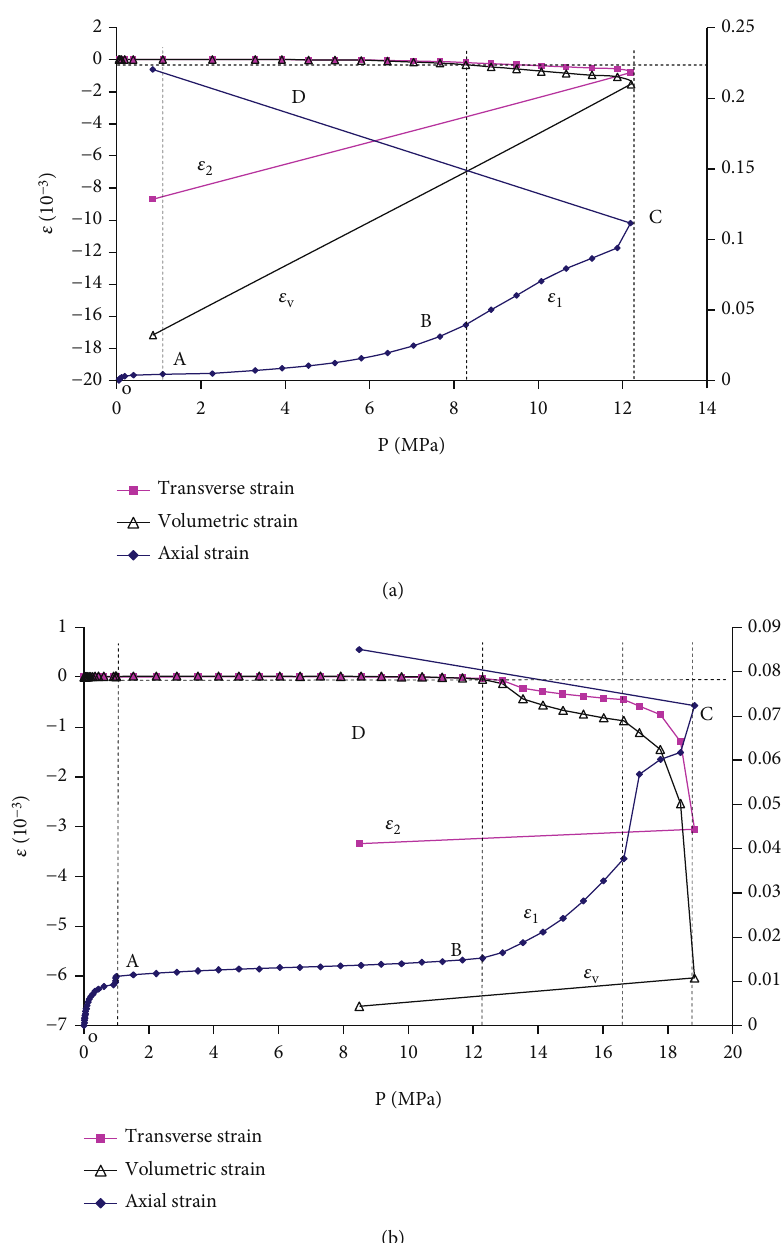
Figure 3: Comparison of the pore water pressure and strain curves of hydrofracture. (a) Uniaxial compression hydrofracture. (b) Triaxial compression